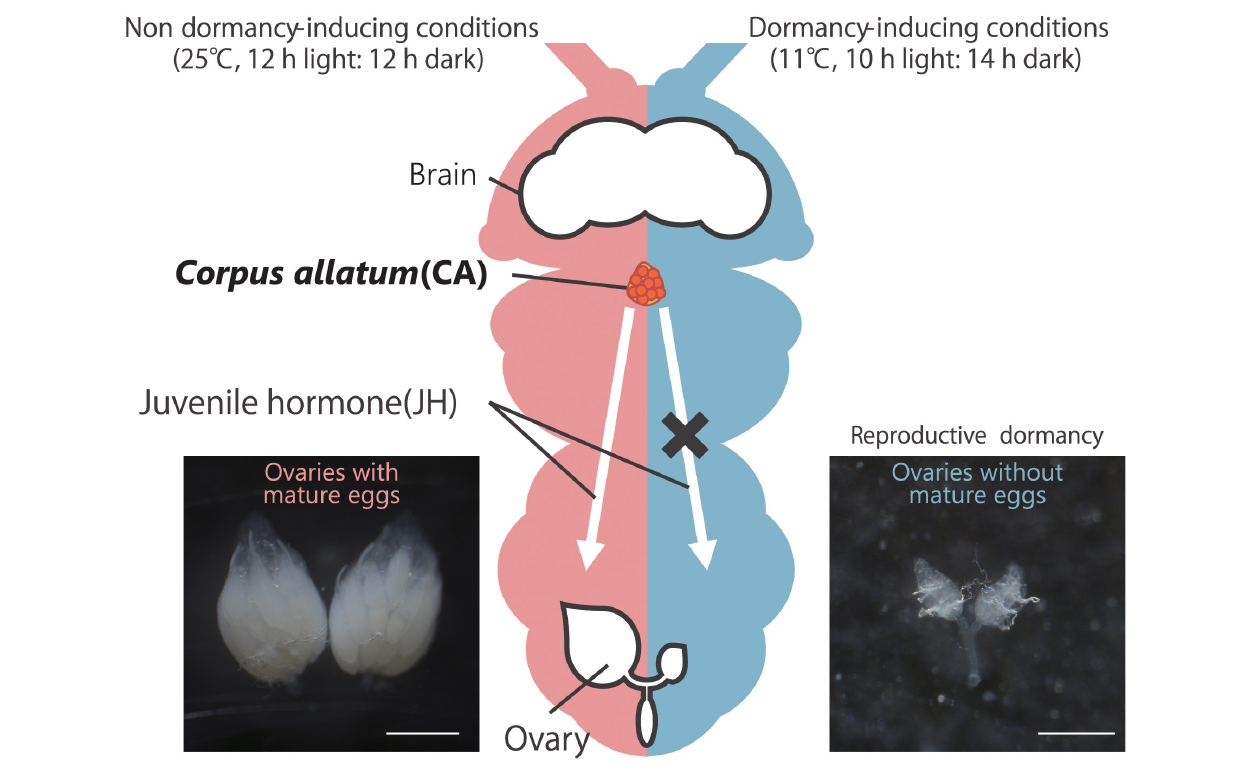
FIGURE 1 | Reproductive dormancy in Drosophila melanogaster adult females. Under non-dormancy-inducing conditions (25 ◦ C, 12 h light:12 h dark; left), approximately 20–60 mature eggs, in which yolk proteins are well accumulated, are observed in the female abdomen. On the other hand, under dormancy-inducing conditions (11 ◦ C, 10 h light:14 h dark; right), oogenesis is severely suppressed, and mature eggs with yolk protein are rarely observed. In non-dormant flies, yolk protein accumulation is positively controlled by juvenile hormone (JH) produced in and secreted from the corpus allatum (CA, orange). Conversely, in dormant flies, JH biosynthesis in the CA is suppressed, leading to the slow-down of oogenesis. Scale bars, 0.5 mm.